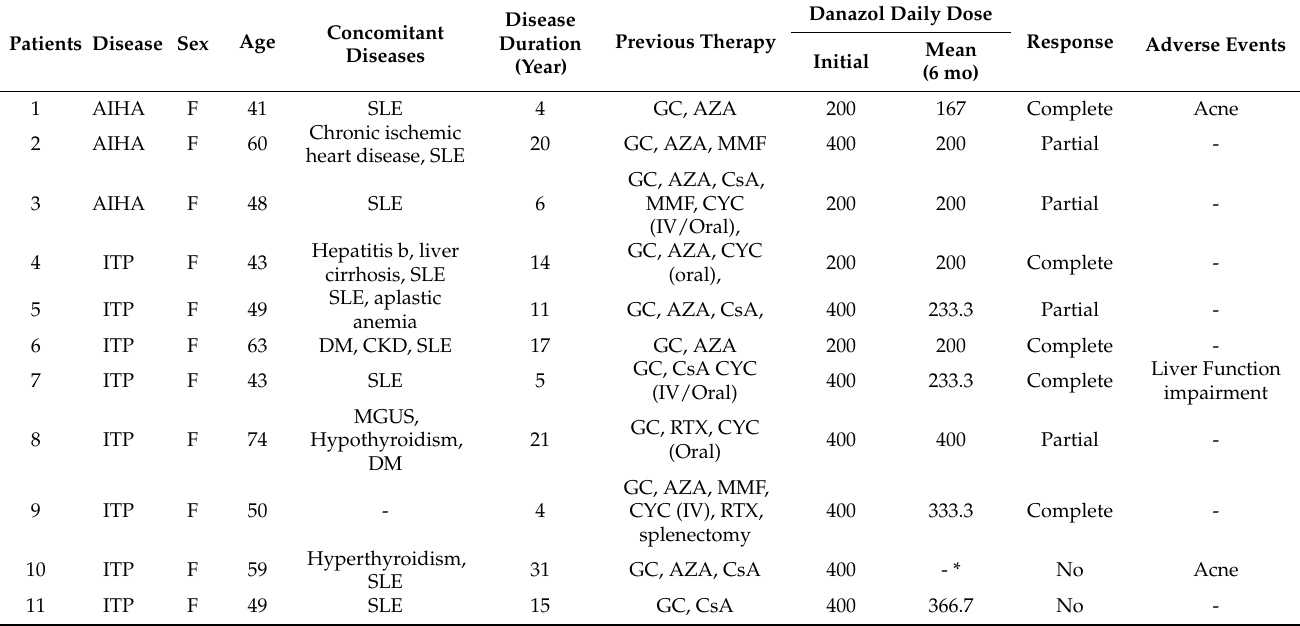
Table 1. The demographics, clinical characteristics, and treatment response of the current